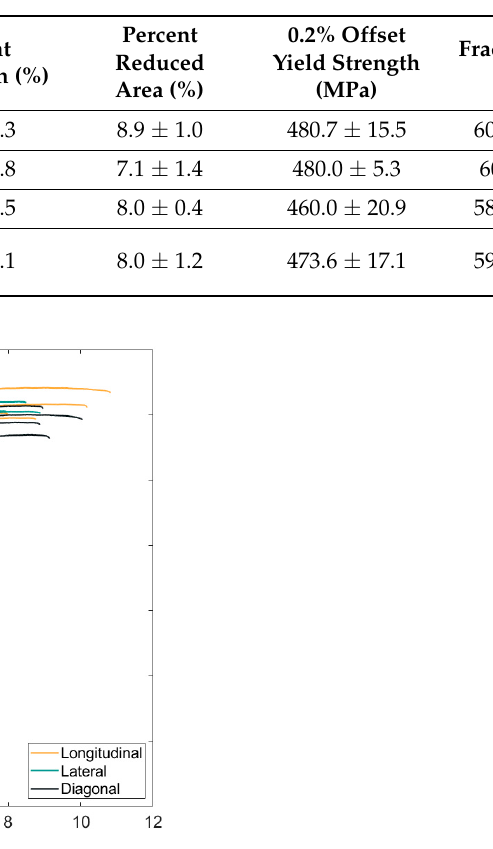
Table 2. Tensile result summary for longitudinal, lateral, and diagonally oriented AM Ti–TiB samples.